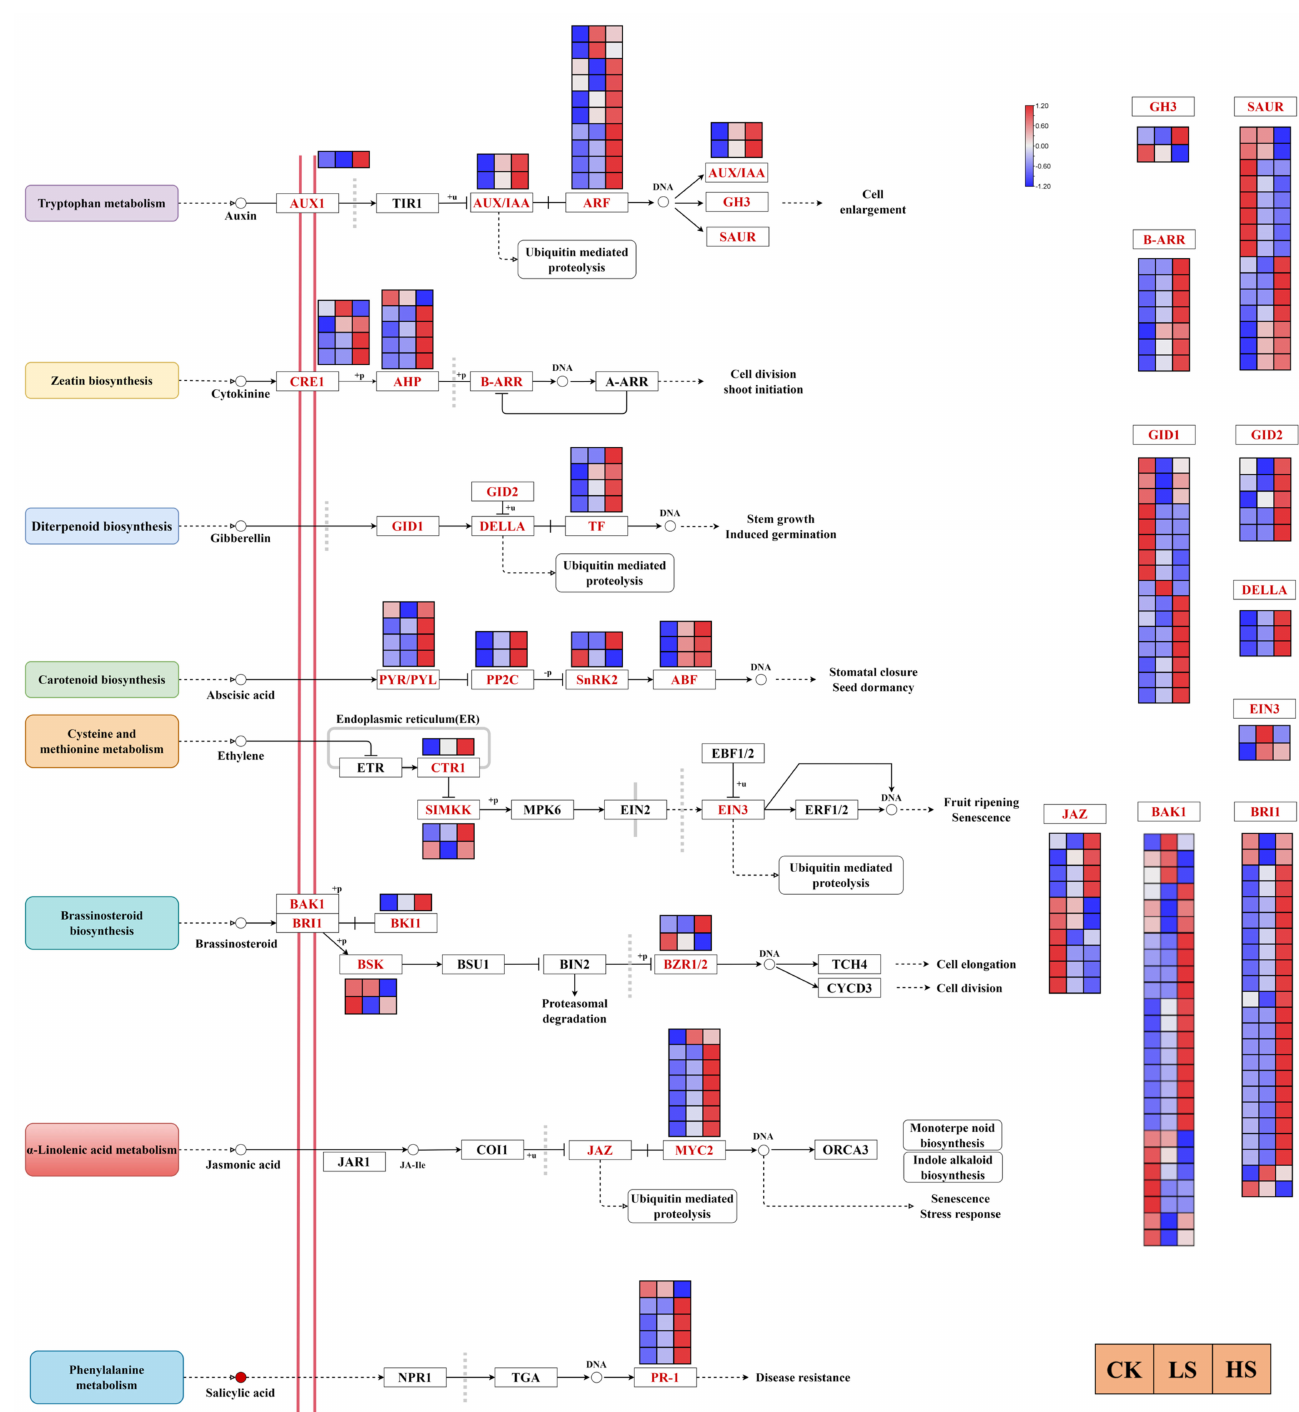
Figure 8. Analysis of DEGs related to phytohormone signaling pathways. The gene expression levels in three samples are shown in different columns in the colored boxes, and different rows represent different genes. CK: control. LS: light shade. HS: heavy shade. The color scale from Min (blue) to Max (red) refers to the expression value from low to